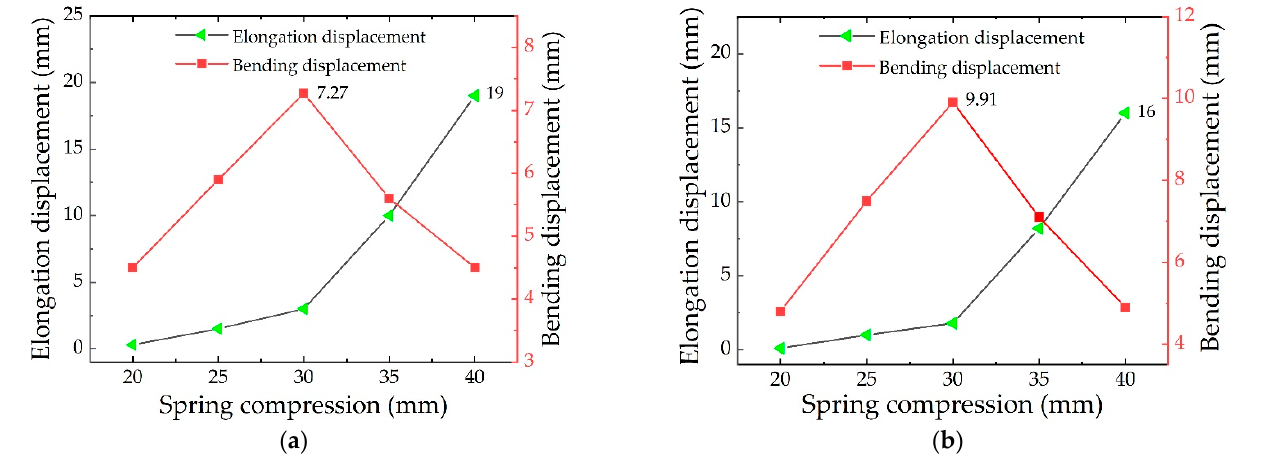
Figure 6. ( a ) the simulation results with the different compressions of the spring for a one-layer DE membrane. ( b ) the simulation results with the different compressions of the spring for a two-layer DE membrane.